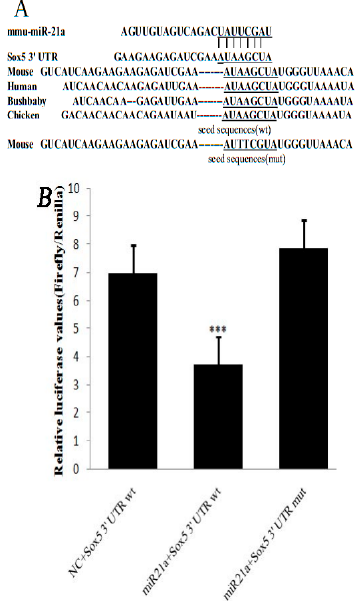
Figure 1. Sox5 is a target of miR-21a-5p: ( A ) the sequences of Sox5 3 ′ untranslated region (UTR) around the miR-21a-5p binding site from its homology across species; and ( B ) relative luciferase activity transfected with reporter constructs containing the wild-type (wt) or mutated (mut) seed sequences of pmiRGL0-Sox5 together with pcDNA6.2™-GW/EmGFP-miR-21a-5p (miR-21a) or the negative control plasmid (NC). The underline sequence are binding site. *** p < 0.001.